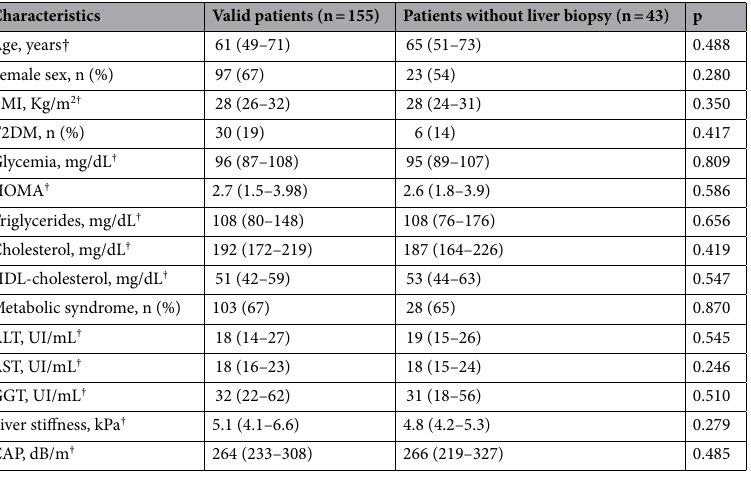
Table 1. Characteristics of the patients included and excluded due to lack of liver biopsy. BMI body mass index, T2DM type 2 diabetes mellitus, HOMA homeostasis model assessment. † Median